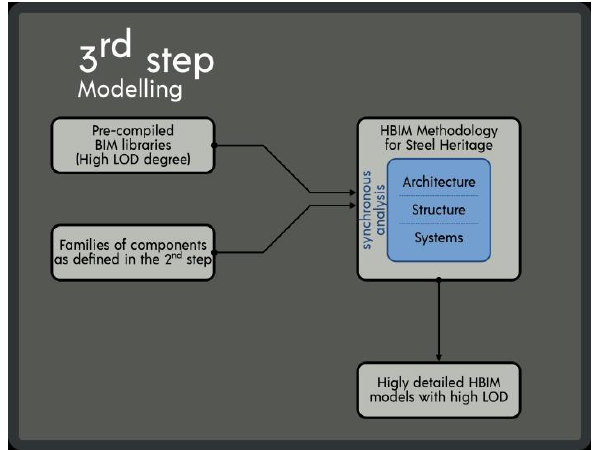
Figure 8: the third step framework, consisting in the modelling. 2017), a separation that permit to different technicians working